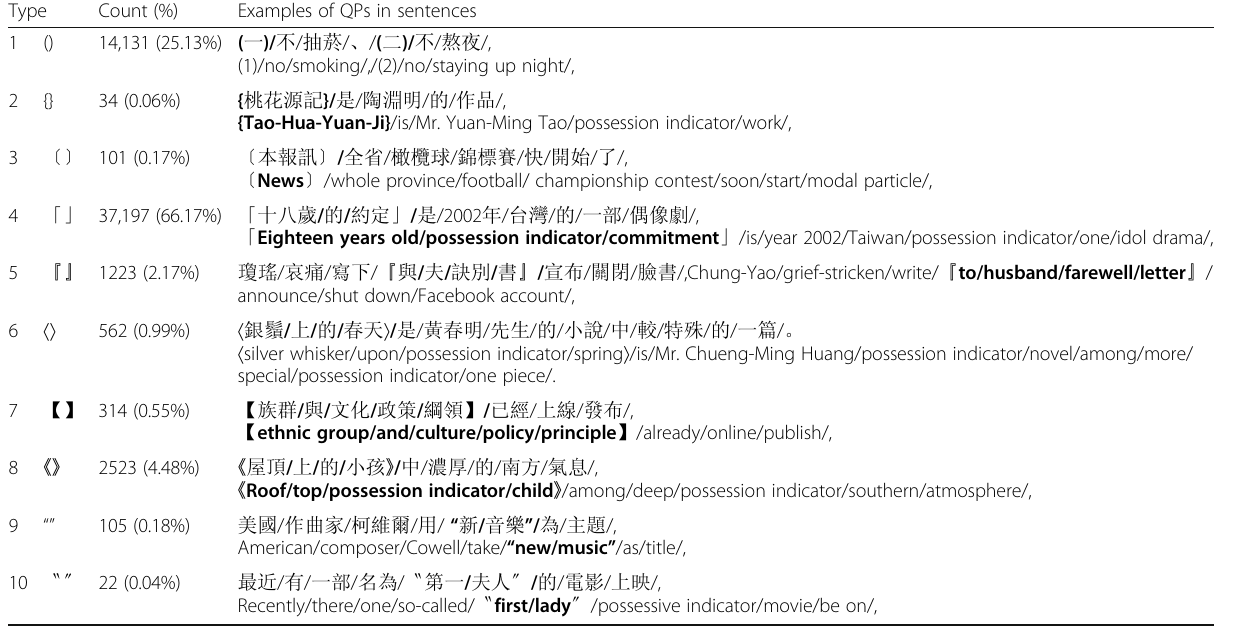
Table 4 Types of QPs, their statistics, and examples in sentences. Note that words in the examples are delimited by slashes and word-by-word English translations of Chinese words are